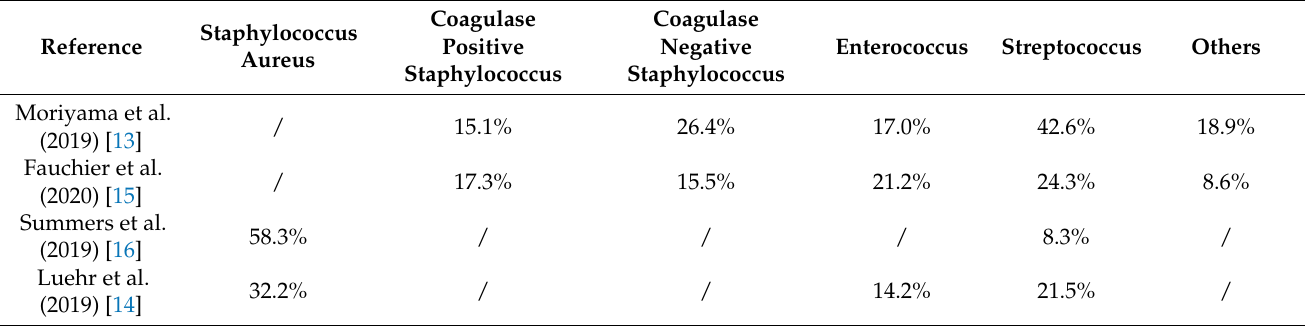
Table 2. Characteristics of the main studies dealing with infective endocarditis in surgical aortic valve replacement (SAVR).